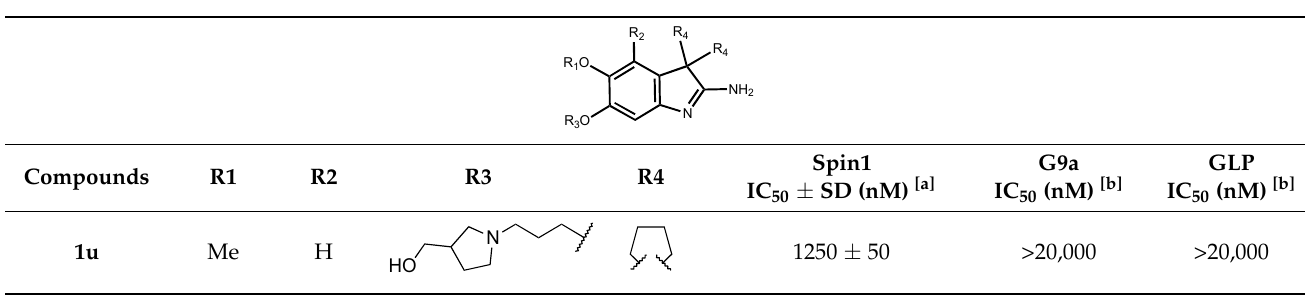
Table 1. Chemical structures and inhibitory activity of the A366 Table 1. Cont.